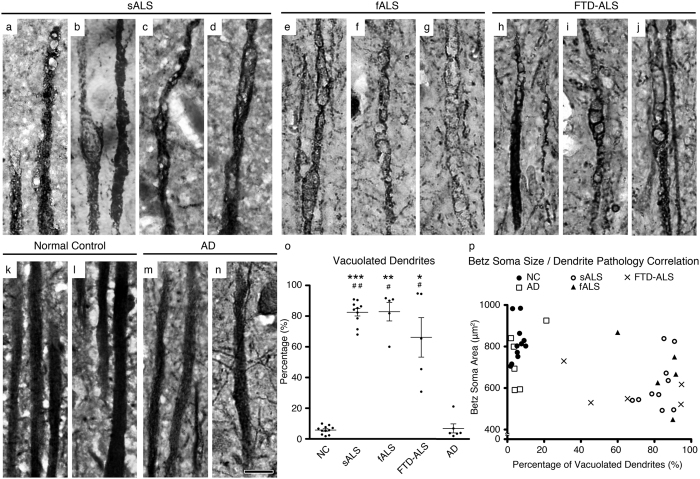
Apical dendrites are filled with vacuoles and disintegrate only in ALS.(a–n) Representative images of prominent apical dendrites that are located in layer IV of the motor cortex in sALS (a–d), fALS (e–g), and FTD-ALS (h–j) patients and normal control subjects (k–l). Apical dendrites that contain vacuoles and show signs of degeneration are marked with arrows. In contrast to ALS, apical dendrites in AD patients (m,n) are similar to normal controls and lack signs of degeneration. (o) Scatter plots represent mean percentage ± SEM of apical dendrites containing vacuoles in all diseased cases studied. Normal controls versus diseased cases studied *P < 0.05, **P < 0.01, ***P < 0.001. AD versus diseased cases studied #P < 0.05, ##P < 0.01. One-way ANOVA (Kruskal-Wallis test) with post hoc non-parametric Dunn’s multiple comparison test. (p) Scatter plot representing average Betz soma area plotted against percentage of apical dendrites containing vacuoles for each subject. Abbreviations: NC: normal control, sALS = sporadic ALS, fALS = familial ALS, FTD-ALS = frontotemporal dementia and ALS, and AD = Alzheimer’s disease. Scale bar = 10 μm.